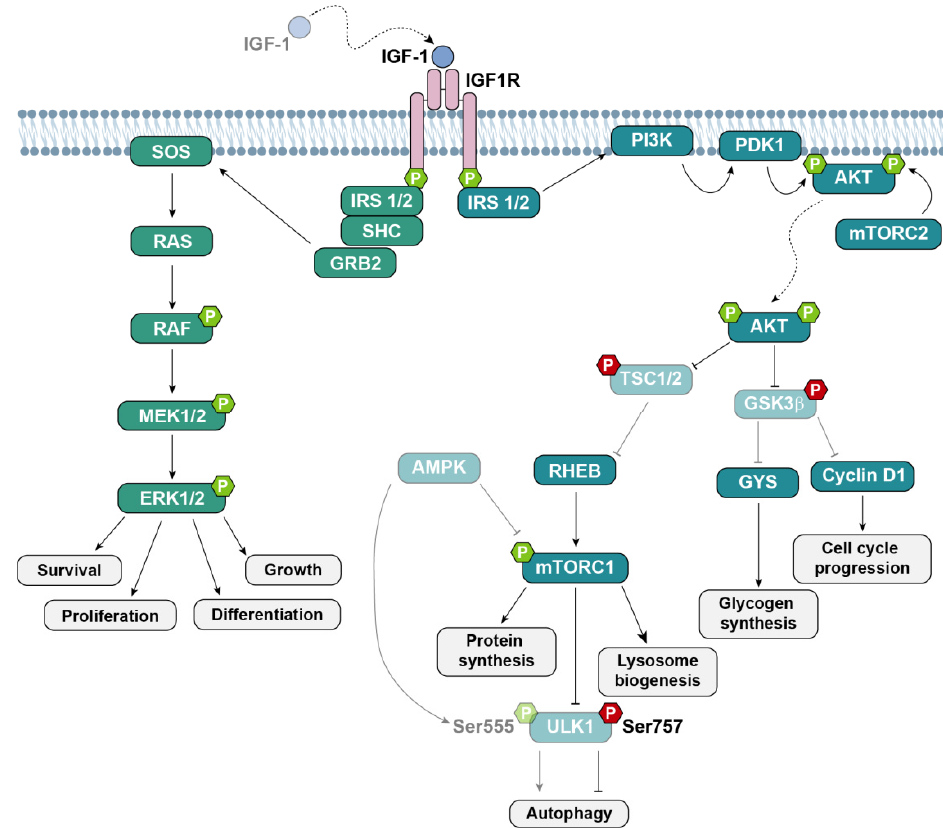
Figure 1 . IGF-1 signaling controls several pathways through the IGF1R/AKT and IGF1R/ERK cascades. Binding of IGF-1 to IGF1R leads to receptor activation through autophosphorylation. Activated IGF1R, in turn, phosphorylates several docking proteins, which serve as signaling nodes for the activation of two main pathways: the PI3K/AKT/mTOR pathway and the ERK MAPK cascade. Both pathways are involved in the regulation of highly relevant cellular processes such as the proliferation, survival and synthesis of macromolecules. P indicates phosphorylation sites, and red and green hexagons indicate inhibition and activation, respectively, by phosphorylation.